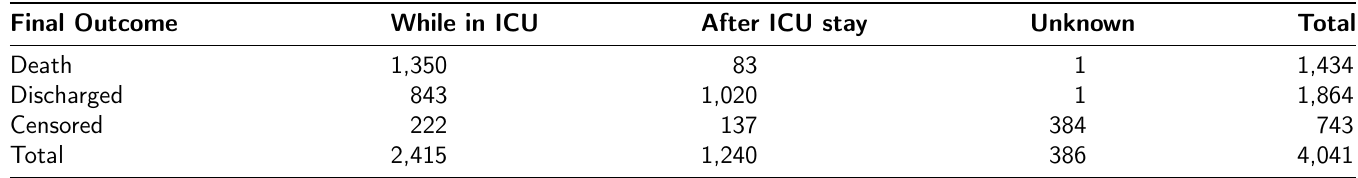
Table 1: Number of records of ICU stays by final outcome and when the outcome